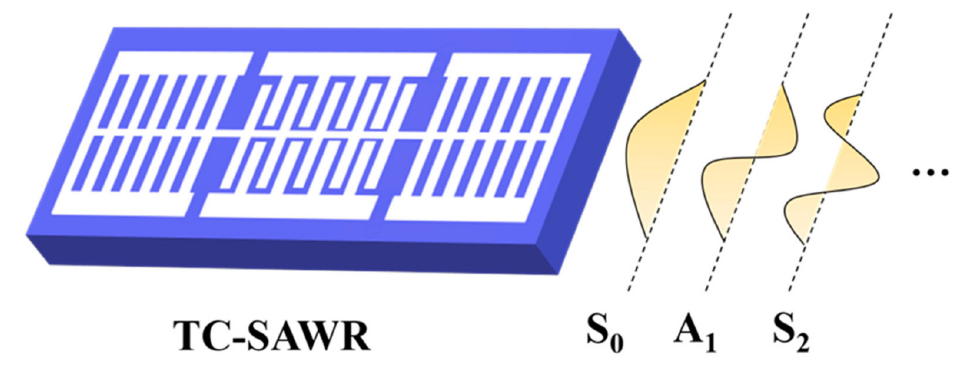
Figure 2. Basic structure of TC-SAWR and its transverse resonance